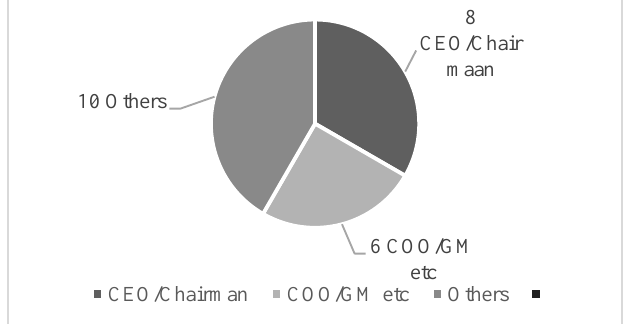
Fig. 2. Professional level of expert group respondents These twenty-four respondents had